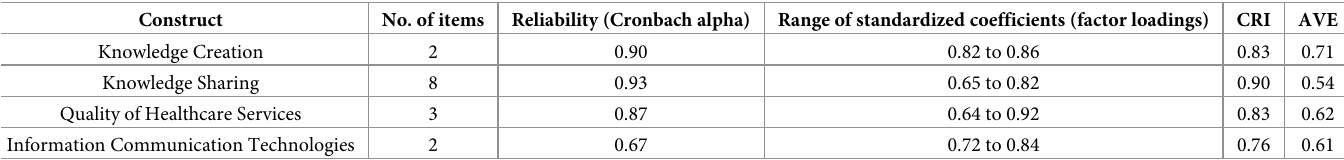
Table 1. Confirmatory factor analysis